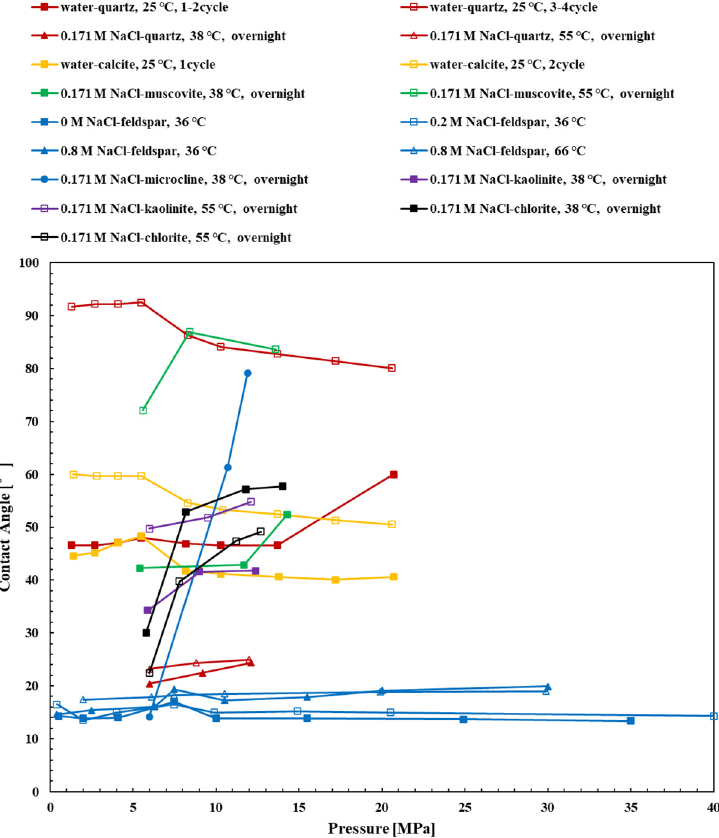
Figure 2. Water contact angle as a function of pressure, temperature and salinity in the CO 2 -NaCl brine-mineral systems after minerals reacted with CO 2 for various periods [36,38,40]. Pressure increased from 1.4 MPa to 20.7 MPa and then decreased to 1.4 MPa again as 1 cycle [36].